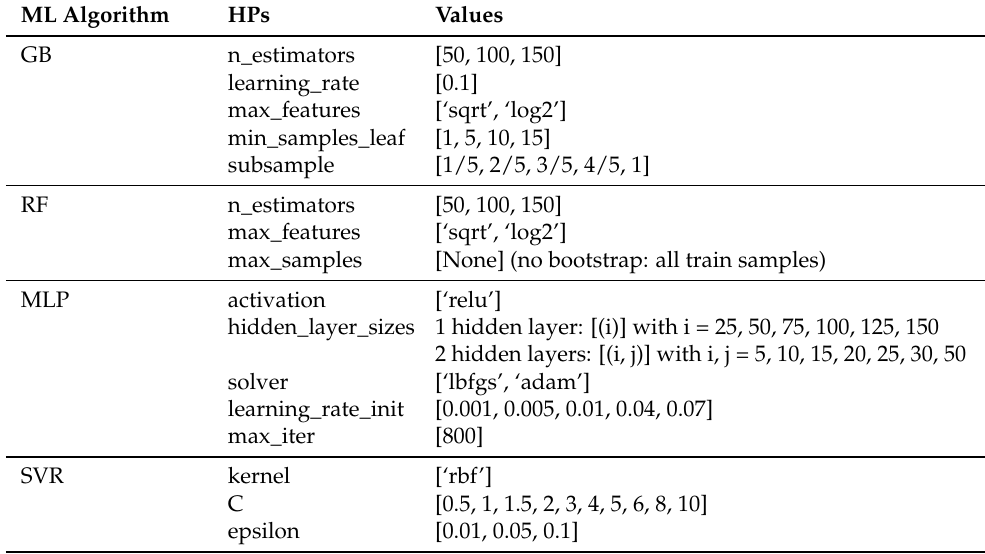
Table 2. HPs tested for GB, RF, MLP and SVR models. ML